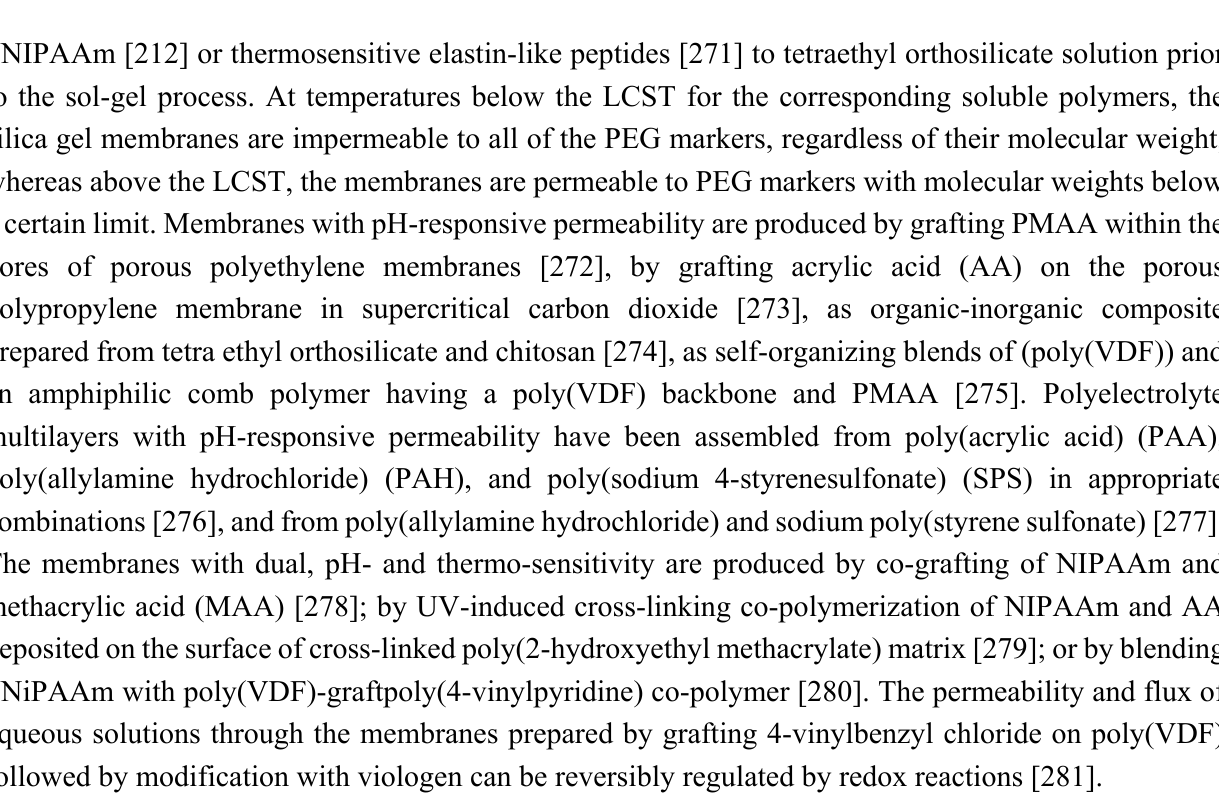
Figure 23. Confocal images demonstrating the release of rhodamine 6G from the polymer-grafted particles at 50 °C: ( A ) at t = 0 min; ( B ) at t = 7 min; ( C ) Fluorescence intensity line profiles taken from the horizontal midline of the image of the particle as a function of time. Reprinted from Reference [267] with